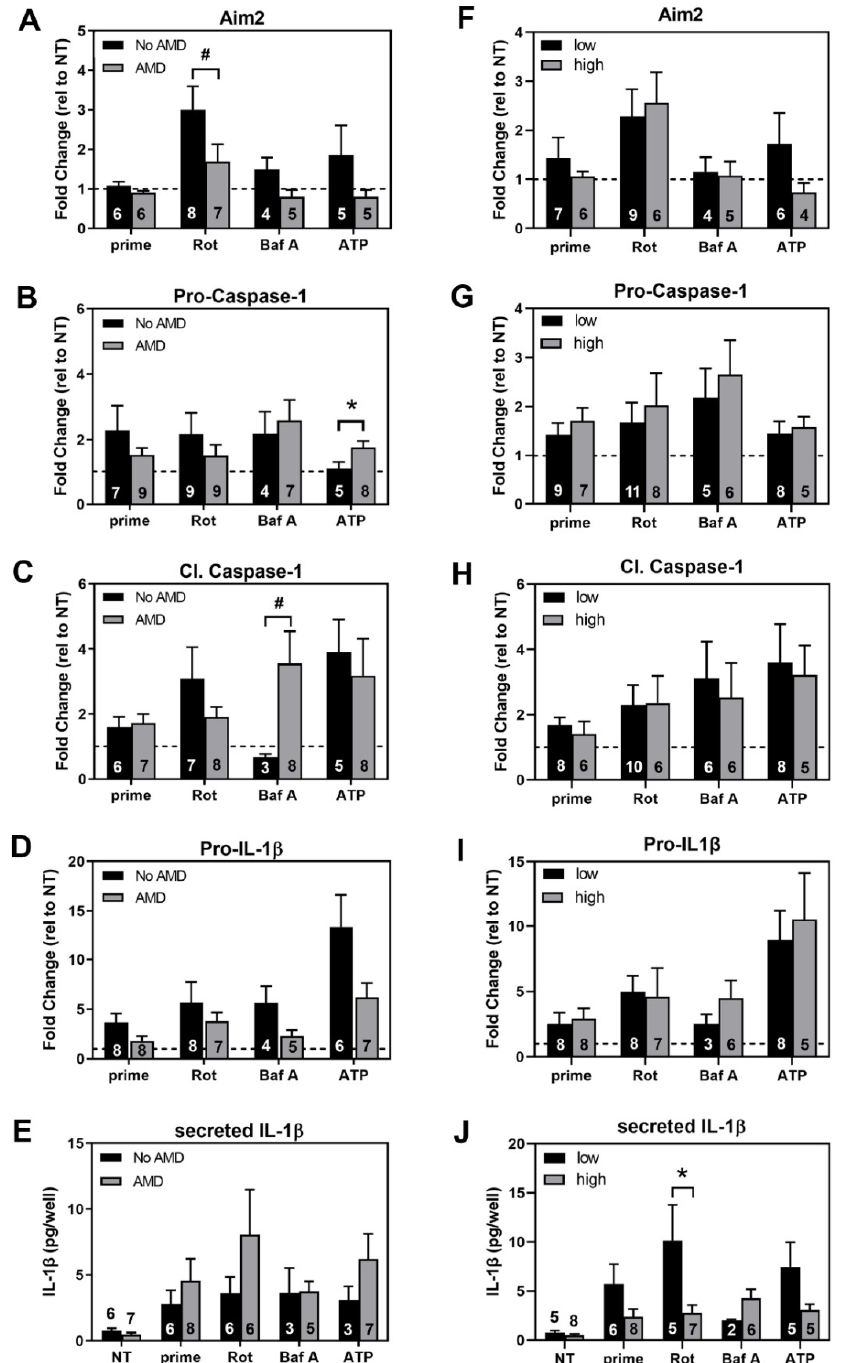
Figure 6. Comparison of Inflammasome Activation in haRPE cells by disease state and genotype. The protein content of Aim2, Pro-Caspase-1, Cleaved Caspase-1, and IL-1β were compared in cells from donors with AMD to donors without AMD ( A – E ), and compared in cells from donors with CFH high-risk genotype to a low-risk high-risk ( F – J ). Protein levels were normalized to β-Actin (loading control) and plotted as fold change relative to their treatment controls. Concentrations of secreted IL-1β from exposed cell culture media were determined by ELISA. Data shown are mean ± SEM. # denotes p < 0.1, * p < 0.05, determined by unpaired t -test. Numbers within bars are the number of individual donors used in each assay.